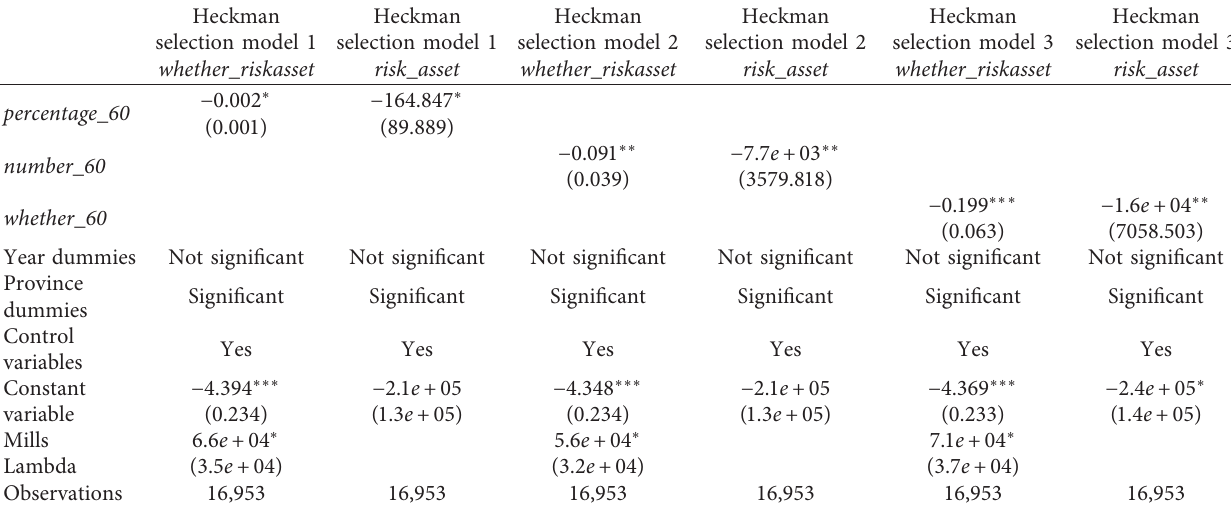
Table 8: Results on families’ risky assets investment using Heckman two-stage model.